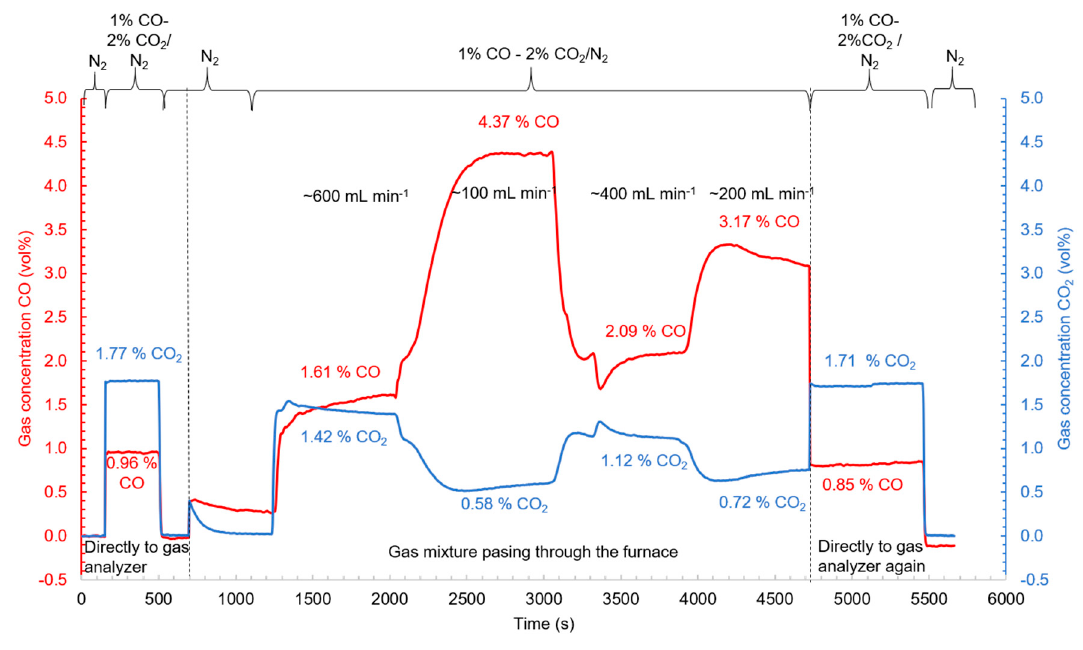
Figure 5. CO-CO 2 gas concentration in Setup 1. Figure 5. CO - CO 2 gas concentration in Setup 1. Figure 5. CO - CO 2 gas concentration in Setup 1.